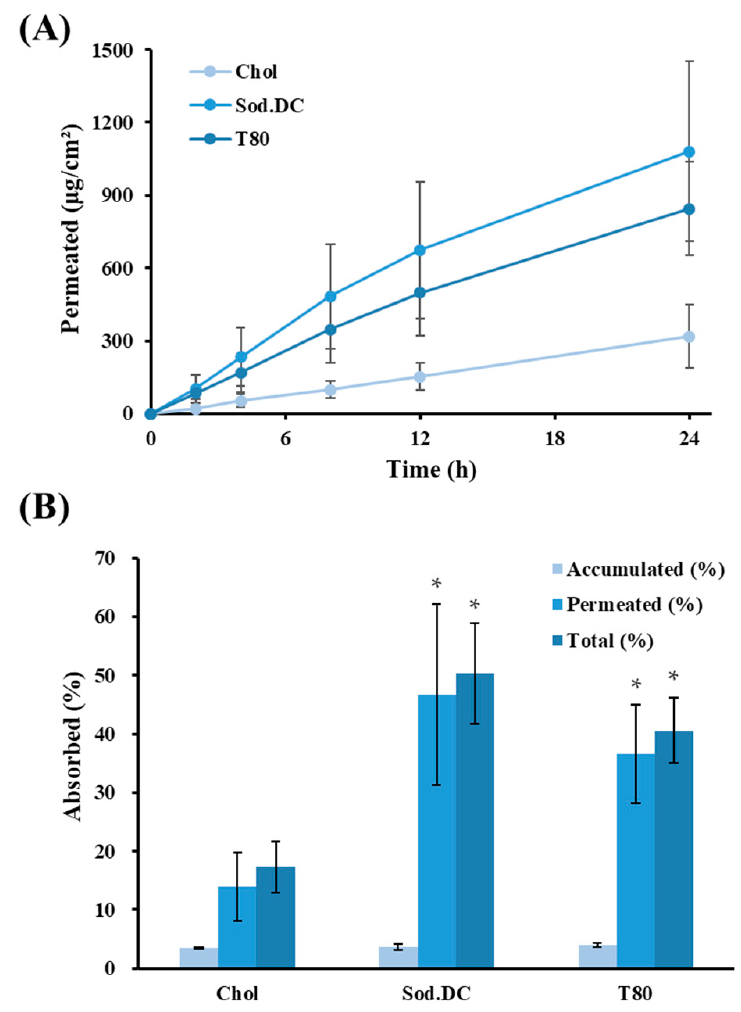
Figure 4. Ex vivo skin absorption of Vit C after topical administration of LOSs prepared with different edge activators. ( A ) Skin permeation profile ( μ g/cm 2 ) of Vit C across porcine skin. ( B ) Percent of Vit C accumulated in the skin, permeated across the skin, and the sum of Vit C accumulated and permeated 24 h post-administration of LOSs. LOSs prepared with cholesterol (L1), sodium deoxy- cholate (L2), and polysorbate 80 (L3) were named Chol, Sod.DC, and T80, respectively. Total ab- sorbed (%) is calculated by dividing the sum of the accumulated and permeated amounts of Vit C by the initially applied amount of Vit C. Data represent mean ± SD (n = 3). * represents significant difference from Chol (* p < 0.05). Table 2. Ex vivo permeation parameters of Vit C after topical administration of LOSs with different edge activators through porcine skins.